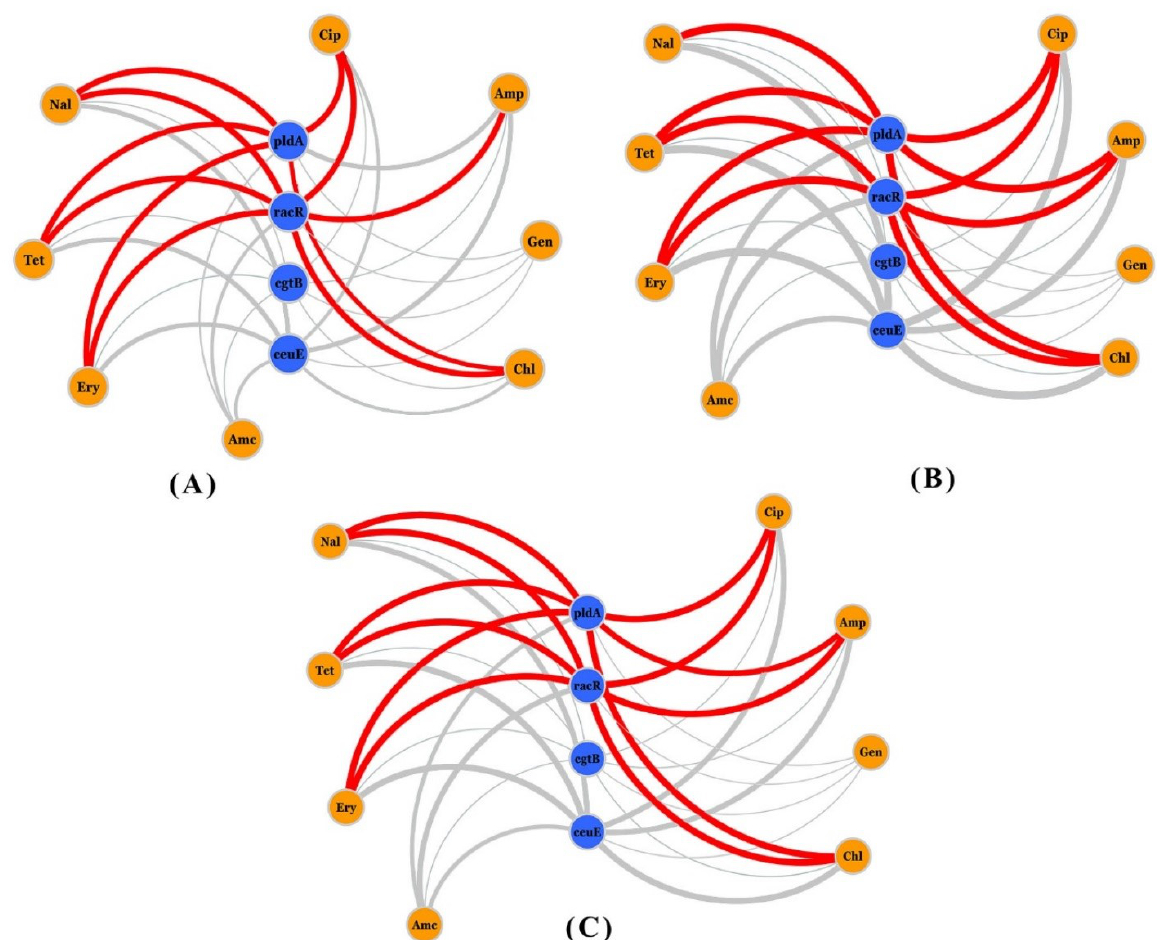
Figure 3. Visualization of the co-occurrence pattern of phenotypic AR and virulence genes across Campylobacter isolates (only virulence genes that showed a statistically significant association were used). Red lines indicate a high incidence of links between AR and virulence among isolates. The line thickness between the nodes reveals the frequency of isolates with identical coincident connections. Nodes in orange and blue are AR and virulence genes, respectively. ( A ) Connections between phenotypic AR and virulence genes across 50 Campylobacter isolates out of 177 isolates. ( B ) Connections across 100 Campylobacter isolates out of 177 isolates. ( C ) Connections across all Campylobacter isolates ( n = 177). Amp, ampicillin; Amc, amoxicillin/clavulanic acid; Cip, ciprofloxacin; Nal, nalidixic acid; Ery, erythromycin; Tet, tetracycline; Gen, gentamicin, and Chl, chloramphenicol.